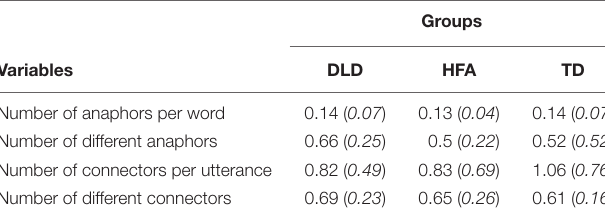
TABLE 4 | Means (M) and standard deviations ( SD ) of anaphors and connectors produced by each group of